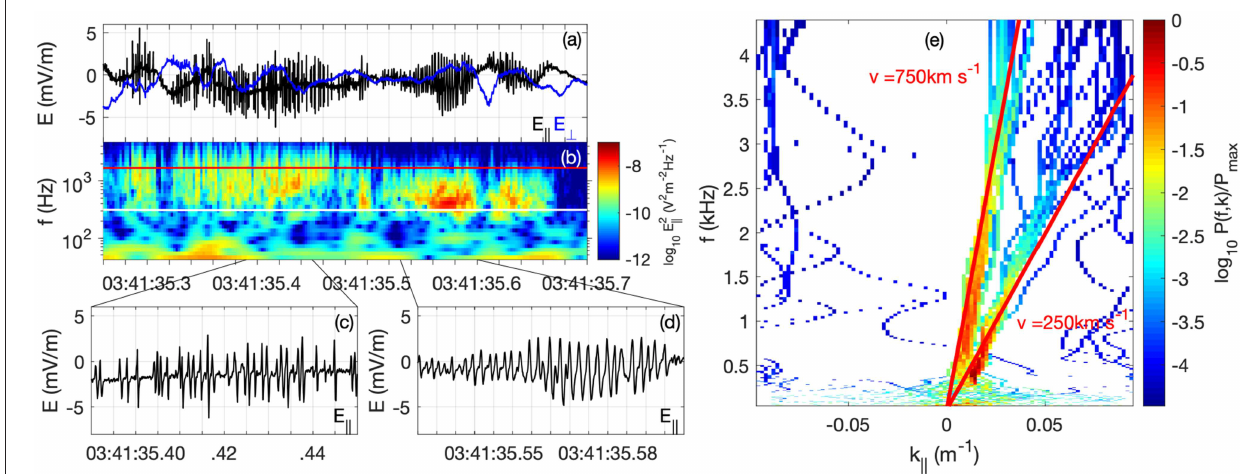
FIGURE 4 | ESWs and electrostatic waves observed at a reconnecting magnetopause by Cluster (Graham et al., 2016b). (a) Waveforms of E Spectrogram of E . The red and white lines are f ce and f pi . (c,d) E k computed using multi-probe